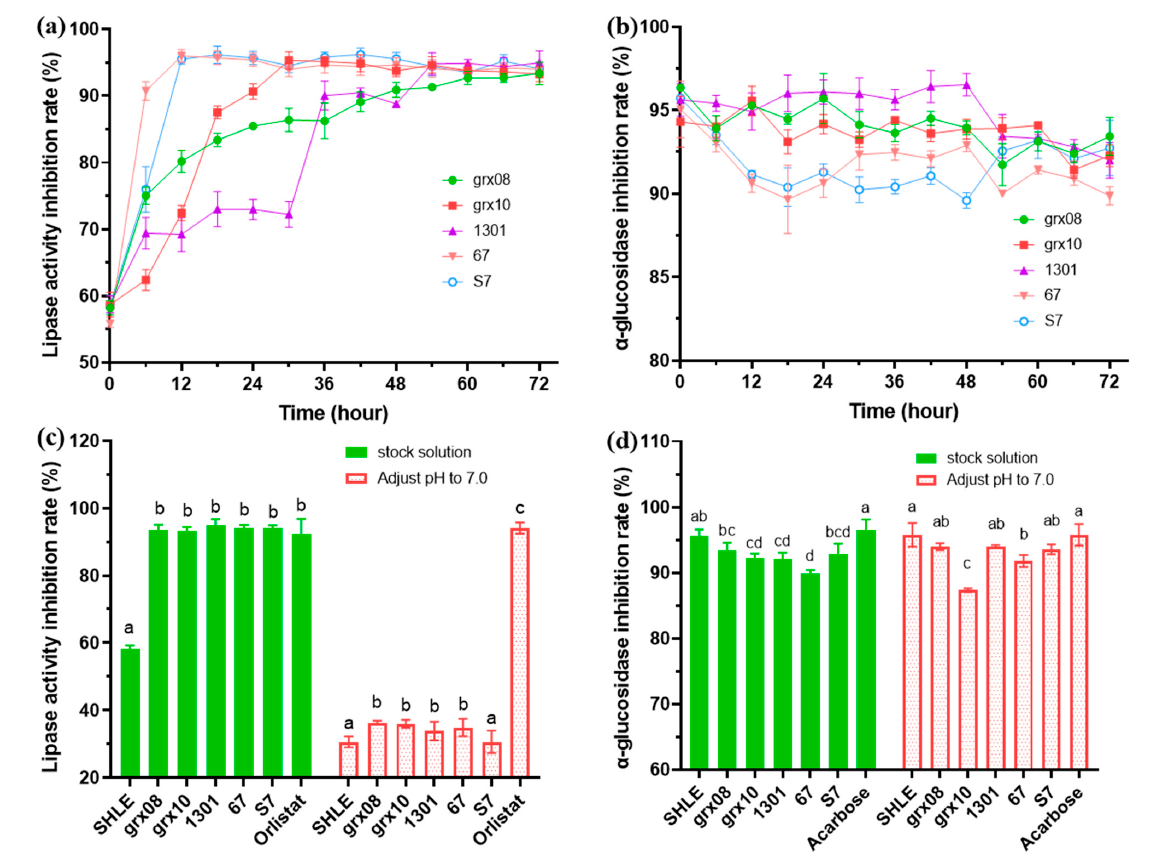
Figure 4. Effects of different LAB fermentations on the inhibition of SHLE energy-digesting enzyme activity. ( a ) The change in lipase activity inhibition rate during fermentation, ( b ) the change in α -glucosidase activity inhibition rate during fermentation, ( c ) inhibition rate of lipase activity in 72 h fermentation samples and ( d ) inhibition rate of α -glucosidase activity in 72 h fermentation samples. Values are expressed as the mean ± standard deviation of replicate experiments ( n = 3). Different letters indicate a significant difference ( p < 0.05).